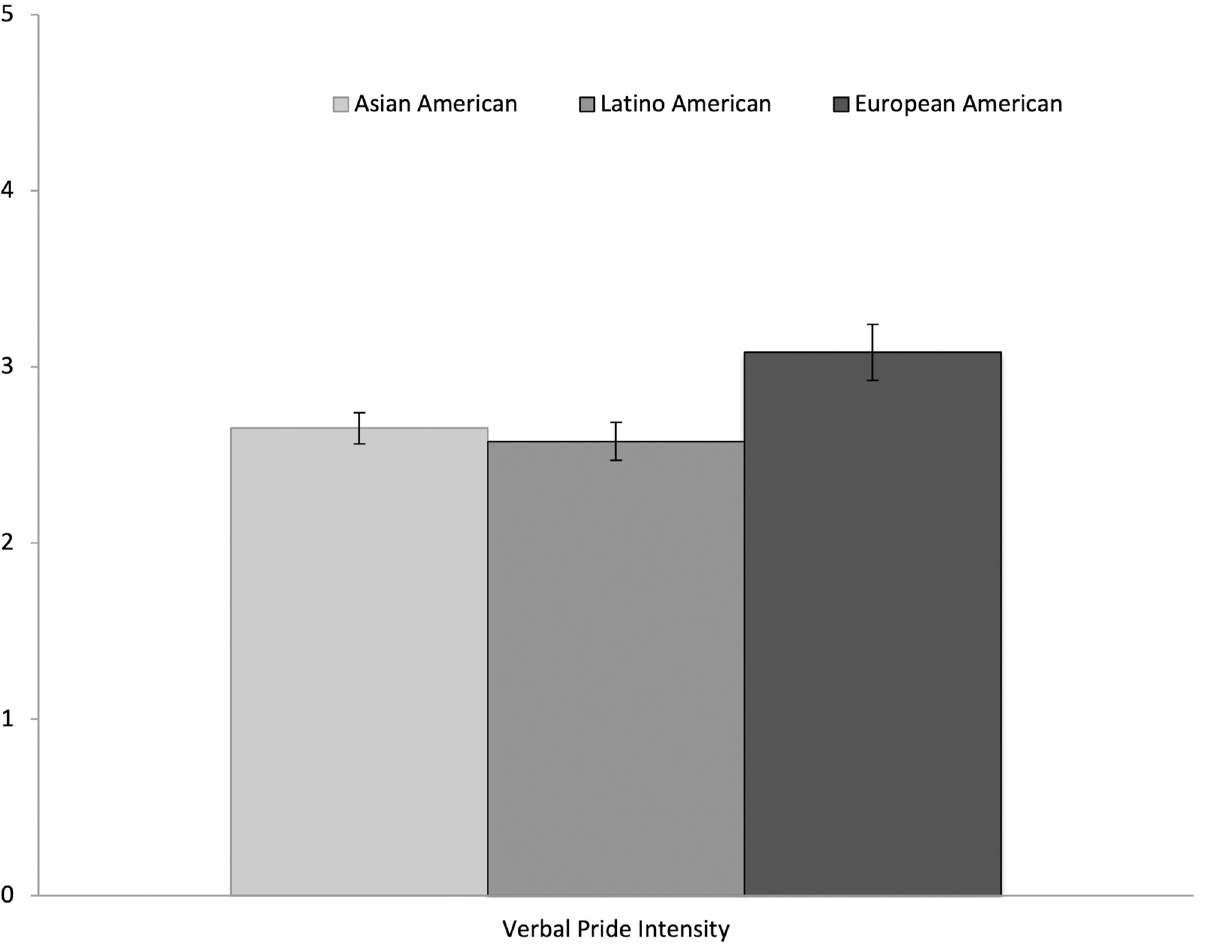
Fig 2. Differences in verbal pride intensity across ethnic heritage. Error bars show the Standard